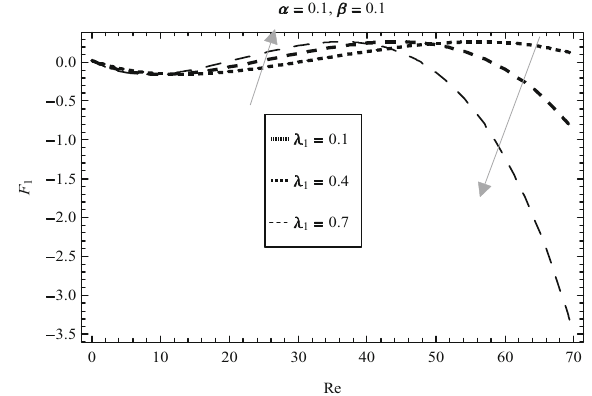
Fig. 20 Variation of F 1 along Re for different values of λ 1